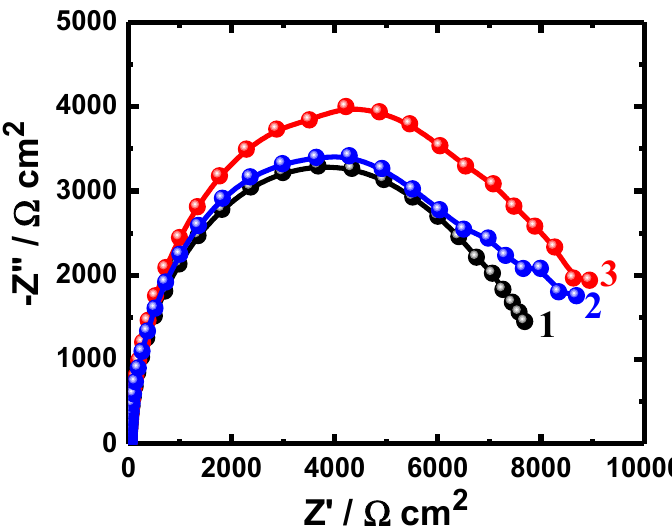
Figure 3. Nyquist plots obtained for (1) PS, (2) PSC1, and (3) PSC2 after their immersion in 4% NaCl solution for 48 h.